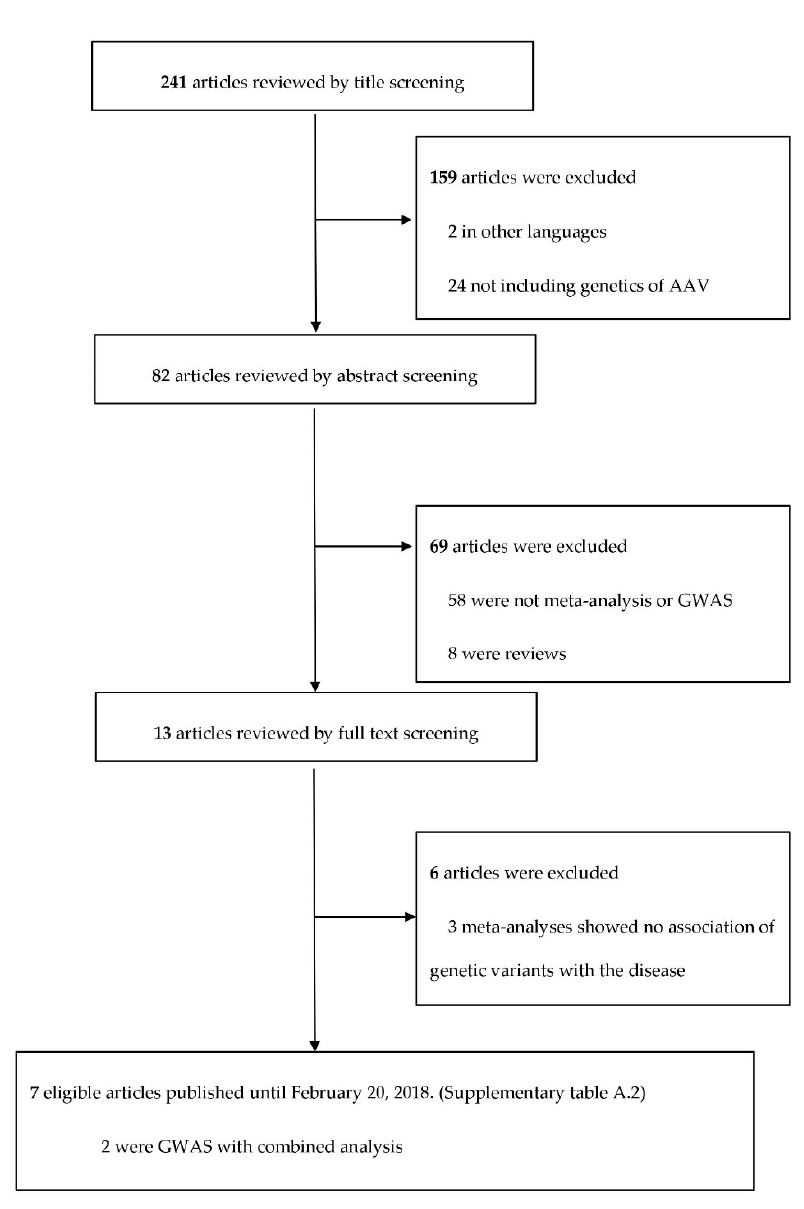
Figure 1. The process of the systematic search performed to study genetic variants in ANCA-associated vasculitis. Abbreviations used: AAV (ANCA-associated vasculitis), ANCA (anti-neutrophil cytoplasmic antibody), and GWAS (genome-wide association study).